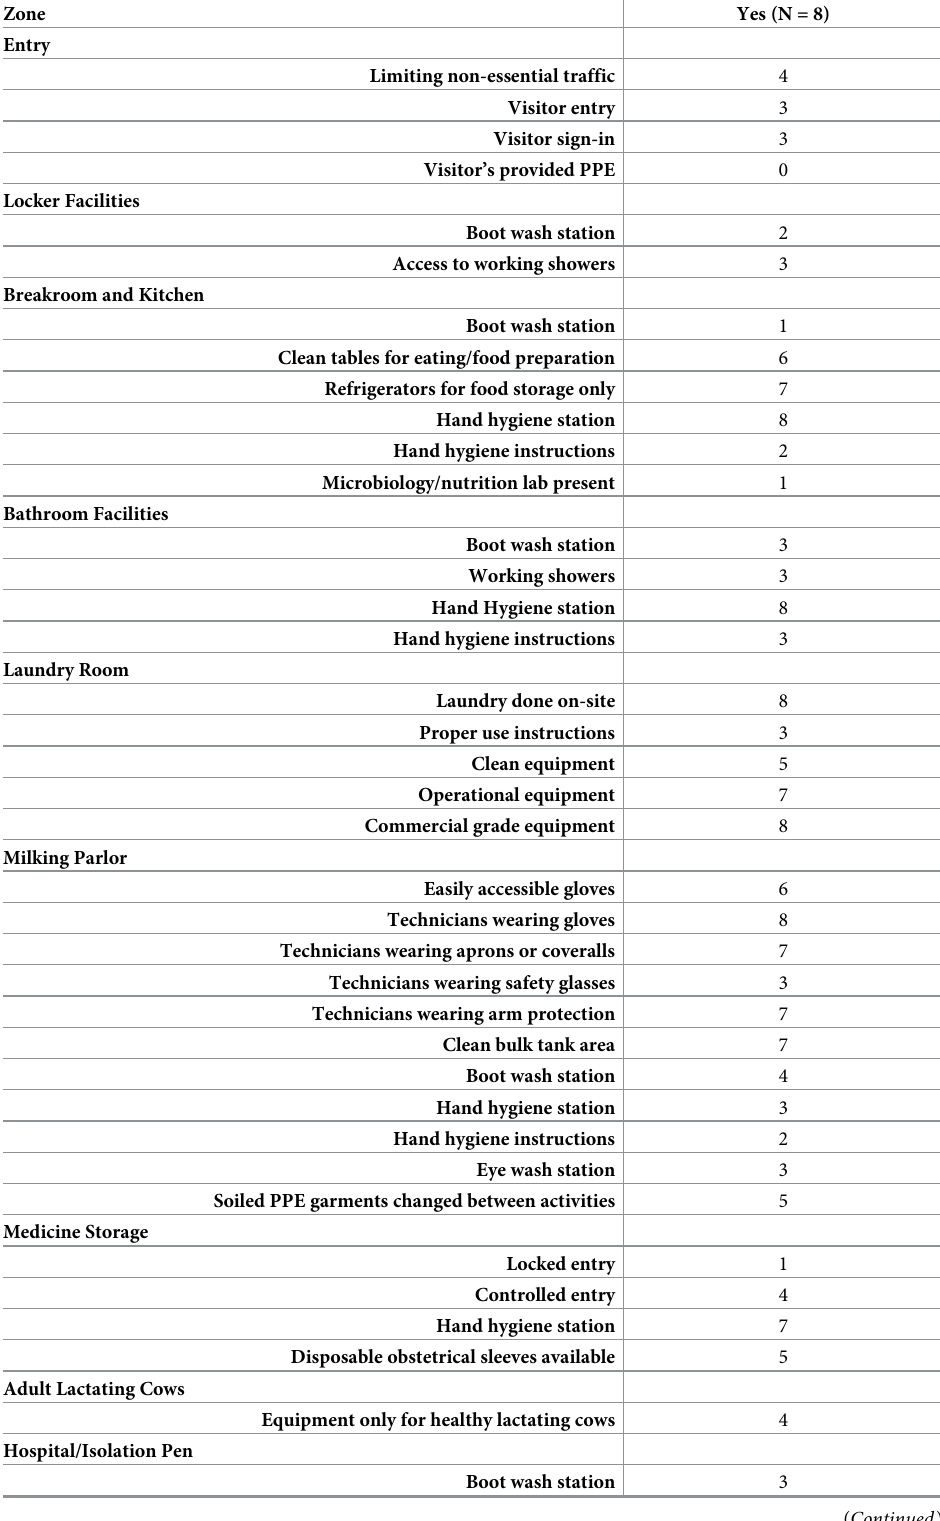
Table 4. Observations of biosafety, personal protective equipment use and availability by farm